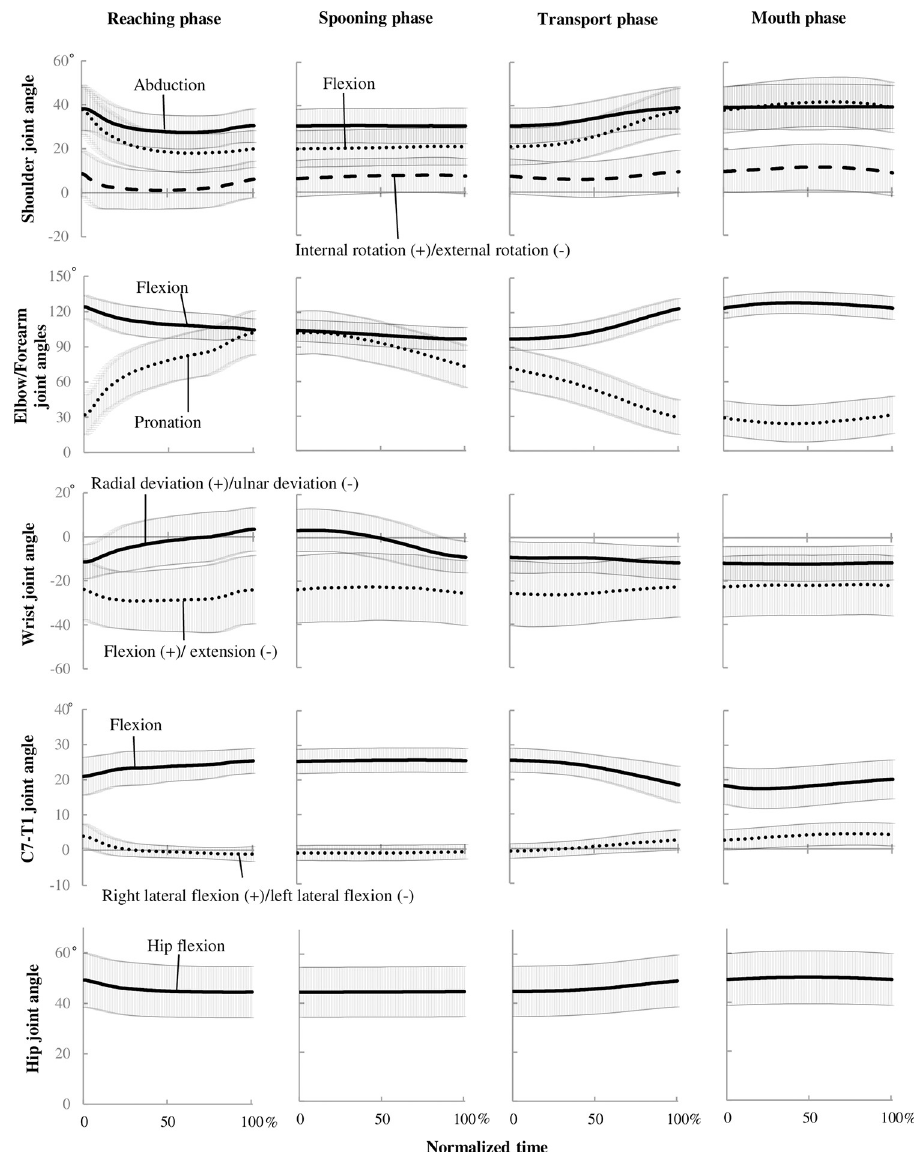
Fig 3. Changes in whole-body joint angles over time for all four eating phases. Solid, dotted, and dashed lines show the mean angles, with shaded areas showing the corresponding standard deviations. dominant and non-dominant hand. In the spooning phase of our study, the mean angles in shoulder flexion and abduction, as well as elbow flexion, were small overall with large mean angles of forearm pronation and wrist radial deviation. Of note, upper limb joint angles in the spooning phases were approximately opposite to those in the mouth phase. The movement patterns of the neck, trunk, and lower limb were specific to each eating phase. Especially, the C7–T1 flexion angle was large, whereas the C7–T1 right lateral flexion and the hip flexion angles were small in the spooning phase, with these angles being respectively reversed in the mouth phase.